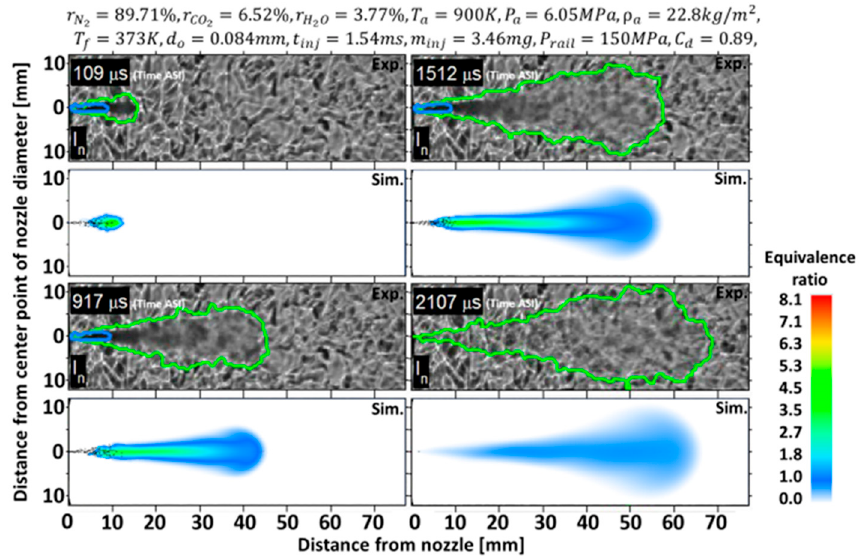
Figure 3. Comparison of the spray shapes and equivalence ratio histories of the experimental result [23] and the simulation result for an ambient temperature of 900 K.